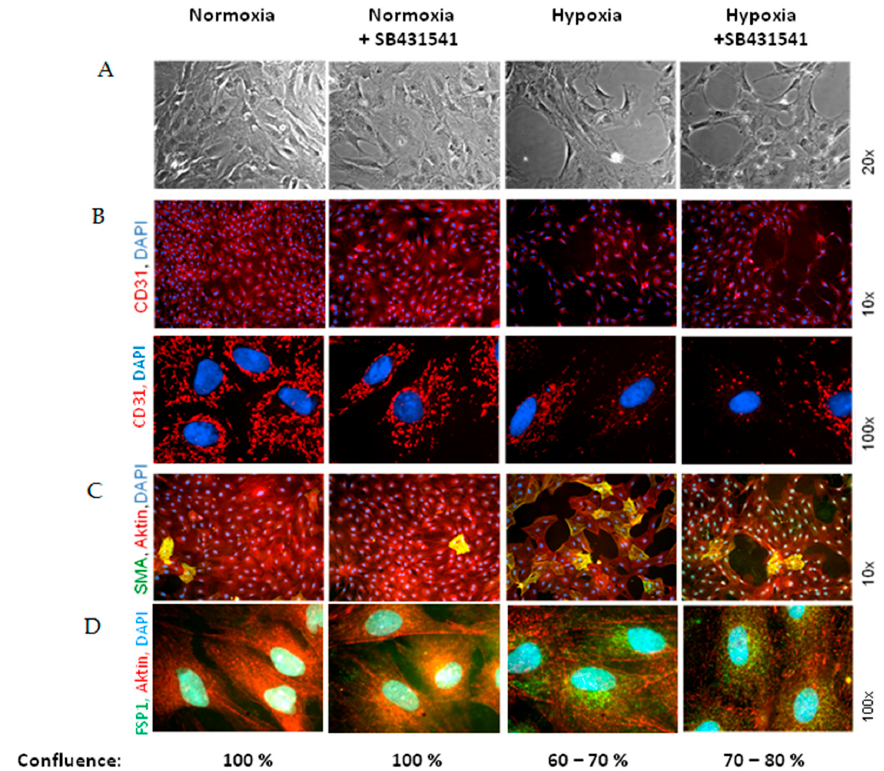
Figure 6. Hypoxia promotes EndoMT via ALK5 receptor. Endothelial cells were exposed to 3 days normoxia or hypoxia in presence or absence of the ALK5 inhibitor SB431542 (1 µM). ( A ) Phase contrast pictures. In these pictures confluence of the cell layer was determined. Additionally, immnuofluorescene was performed: ( B ) double staining with CD31 antibodies (red) and nuclear DAPI-staining ( C ) triplicate staining with α -SMA antibodies (green), actin staining with phalloidin (red), and nuclear DAPI staining (blue), ( D ) triplicate staining with FSP1 antibodies (green), actin staining with phalloidin (red), and nuclear DAPI staining (blue).